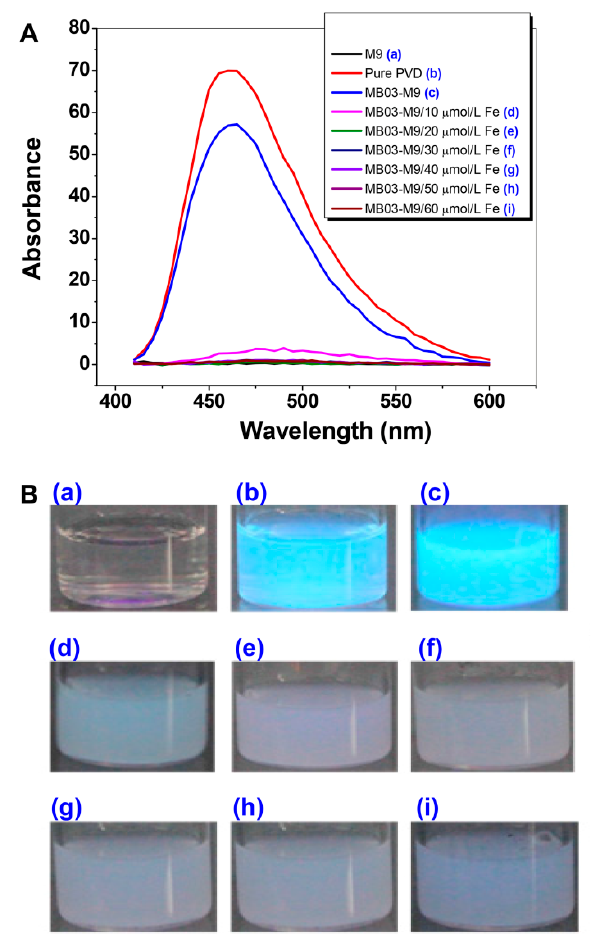
Figure 2. Production of PVD by P. syringae MB03 is negatively controlled by iron. ( A ) Wavelength (400 to 600 nm)-scanning curves of the supernatants of P. syringae MB03 cultures supplemented with different concentrations of exogenous iron. ( B ) Fluorescent supernatants of P. syringae MB03 culture suspensions. ( a ) M9 medium; ( b ) pure PVD; and ( c ) − ( i ), the supernatants from the cultures supplemented with exogenous iron at 0, 10, 20, 30, 40, 50, and 60 µmol L -1 , respectively.